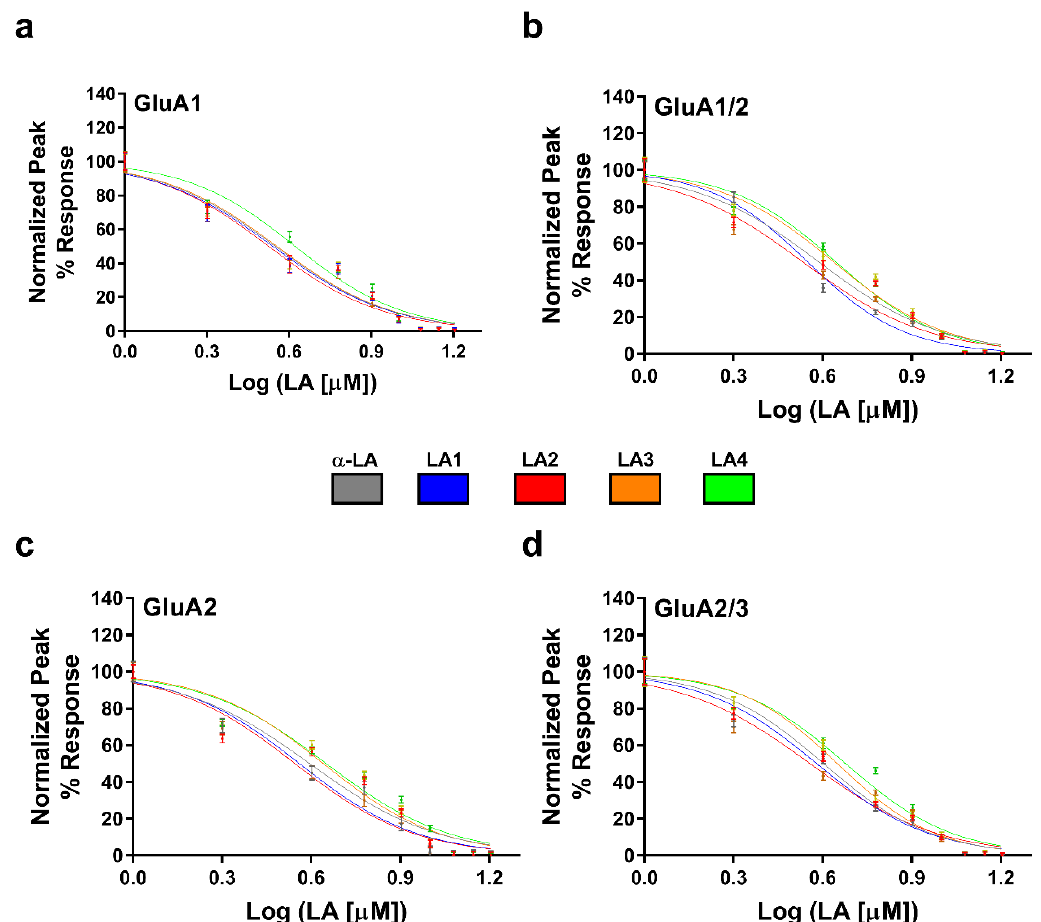
Figure 3. The potency of LA compounds against AMPA receptor subunits. The IC 50 values for LA derivatives on whole-cell normalized peak amplitude in HEK293 cells are shown in ( a – d ). IC 50 values were calculated using GraphPad Prism version 6.01 (GraphPad Software, San Diego, CA, USA), and concentration-response relationships were fitted as composite curves to the Hill equation. The whole-cell current was measured at − 60 mV, pH 7.4, and 22 ◦ C. Each concentration was applied to the cell for 500 ms before rinsing out for 20 ms. Following many washout periods, glutamate (10 mM) was supplied alone, and the instantaneous evoked current was measured. Each data point is the average of three to four different trials.